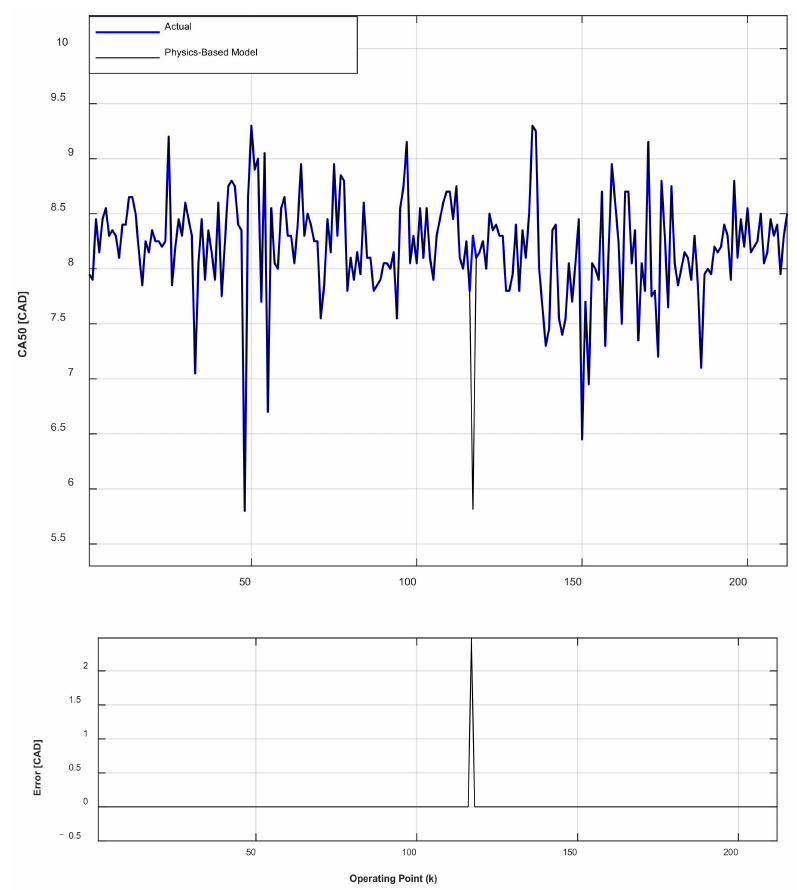
Figure 12. Comparison of the physics-based CA50 model and the actual CA50 trajectory. The physics-based CA50 model returned a PPMCC of ∼ 95.0% and an RMSE of 0.17 CAD with a 49.4 s computational runtime using an iteration convergence tolerance of 1 × 10 − 99 for the online parameter optimization subroutine in an unperturbed